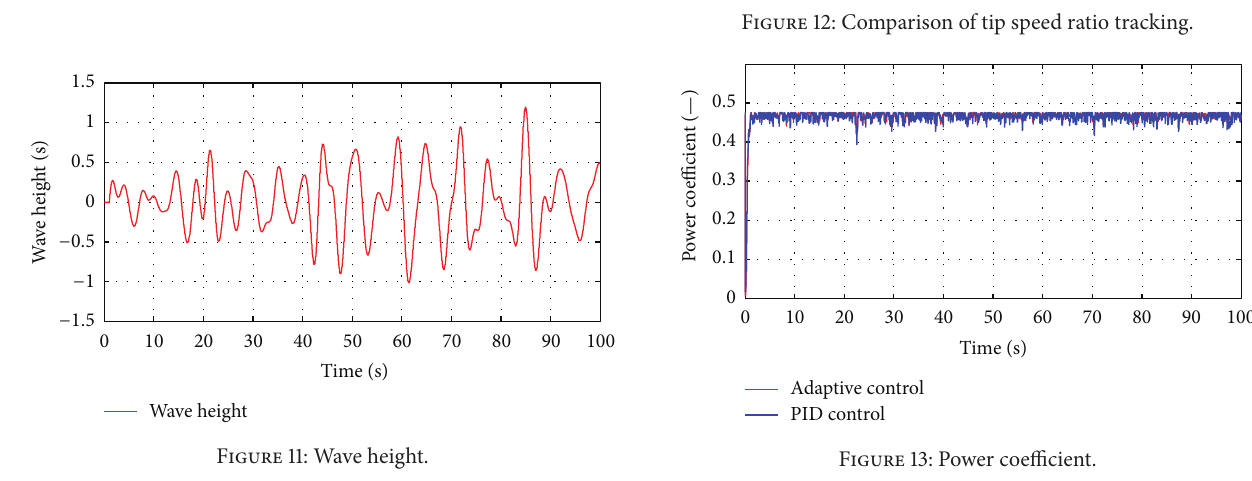
Figure 10: Wind speed.